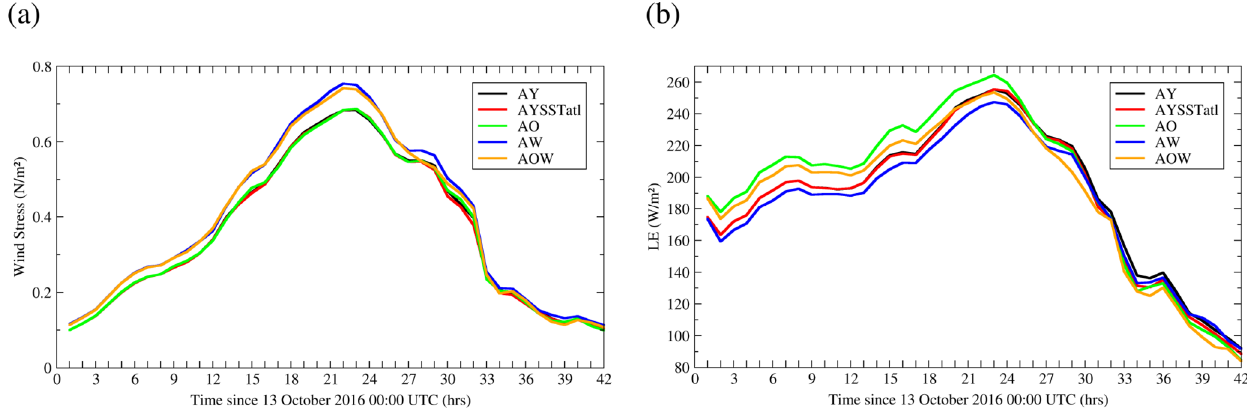
Figure 5. Time series of (a) wind stress (Nm − 2 ) and (b) latent heat flux (LE, Wm − 2 ) on average over the Azur area for forecasts starting at 00:00UTC on 13